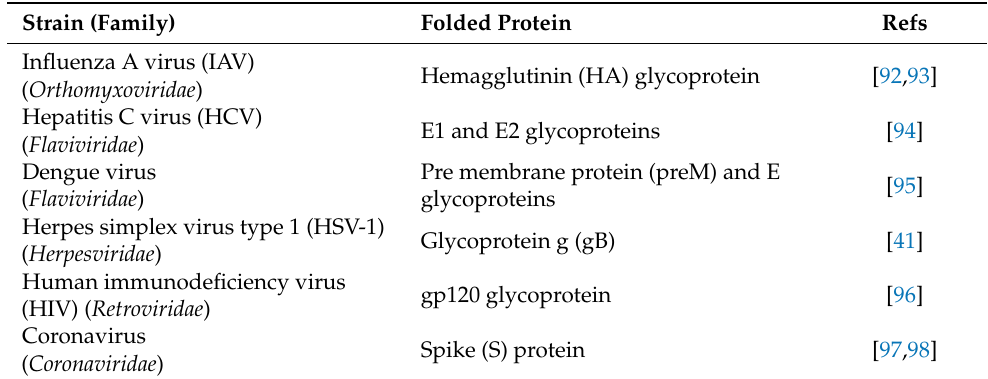
Table 1. Viruses that exploit protein disulfide isomerase (PDI) activity to fold structural proteins. Strain